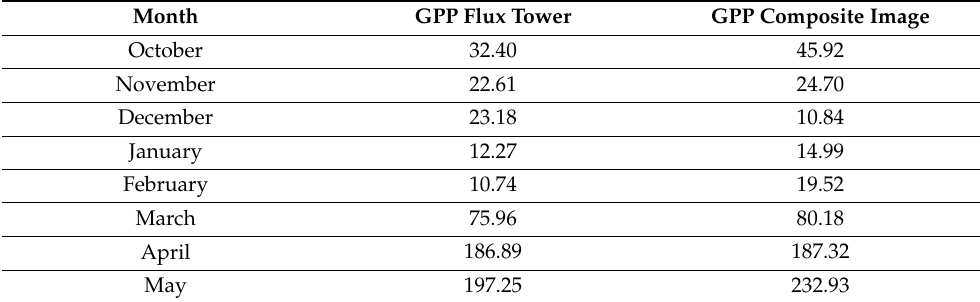
Table 8. Monthly carbon fluxes retrieved from the Duque Fuente flux tower and predicted for